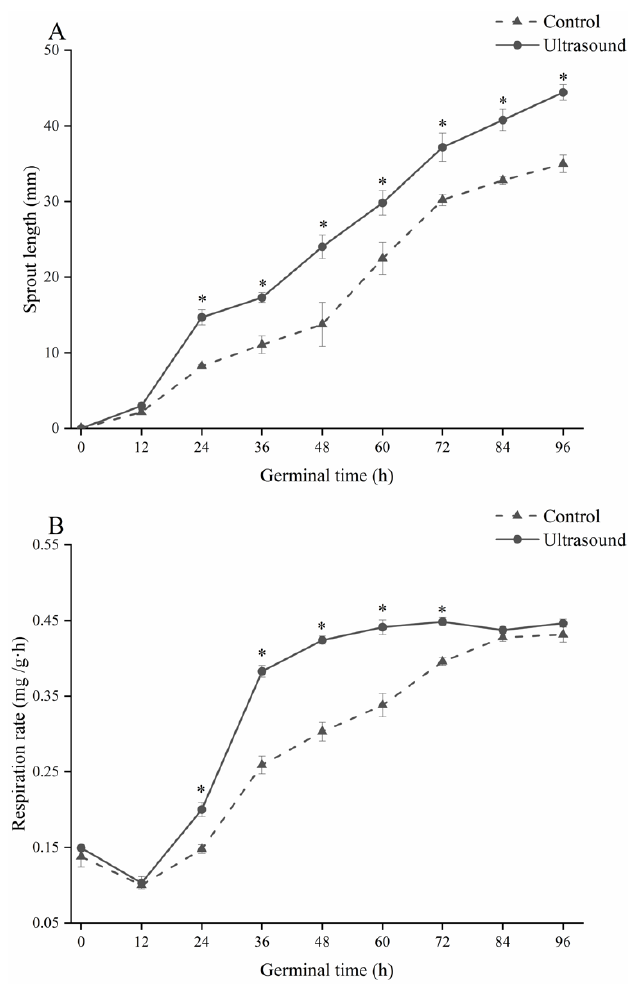
Figure 2. The effect of ultrasound induction treatment on sprout length ( A ) and respiration rate ( B ) during maize germination. * Indicates a significant difference ( p < 0.05) between the ultrasound and control